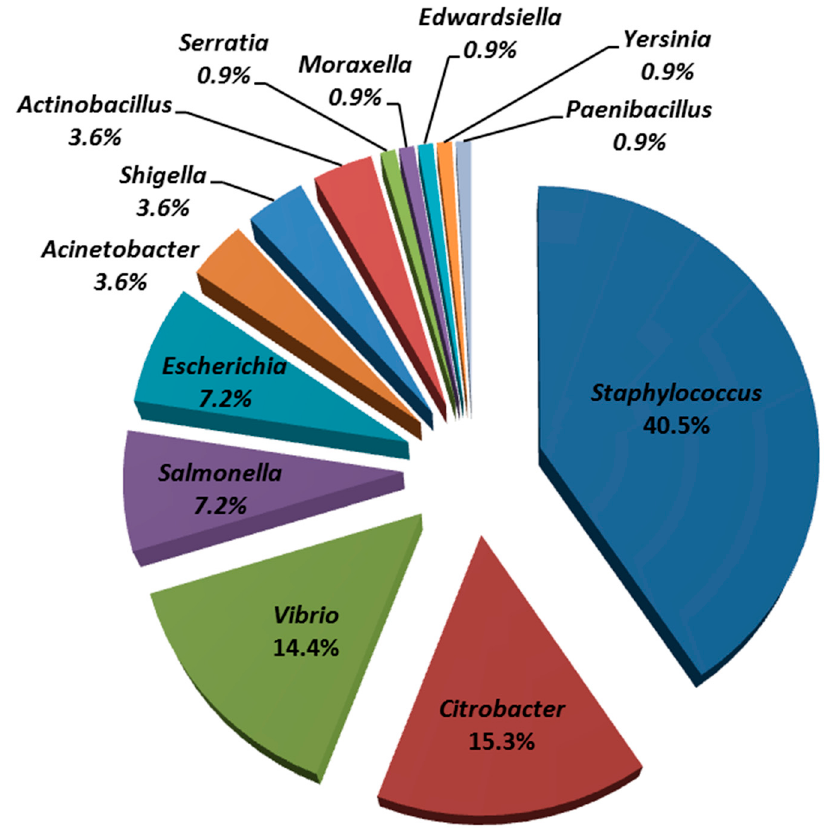
Figure 2. Percentages of bacterial genera ( n = 111) isolated from seawater in juvenile green turtle holding tank at STCCT during the periods 2015 to 2016, 2018, and 2019.